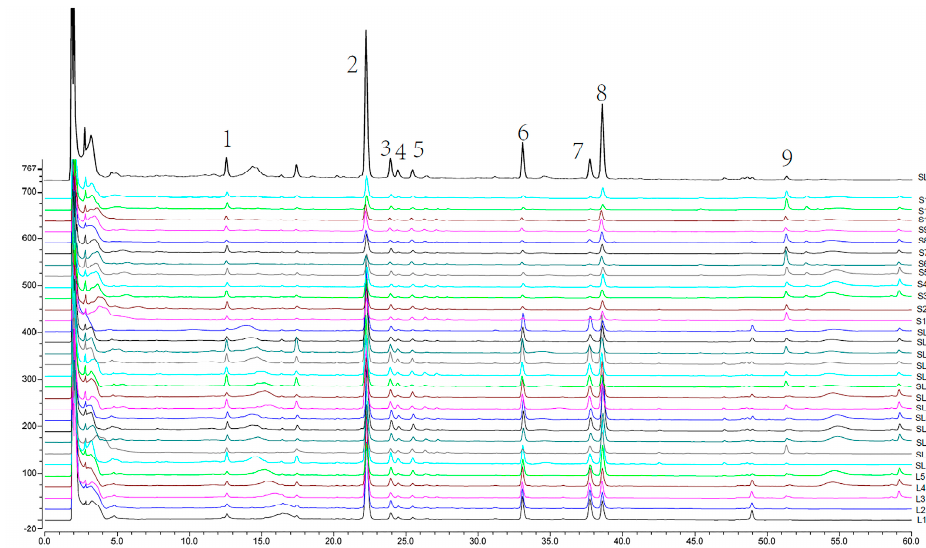
Figure 3. Chromatographic fingerprints of all AH samples. (L1–L5 are leaf samples; SL1–SL13 are stem and leaf mixed samples; S1–S12 are stem samples. Peaks 2,6,7,8 are andrographolide, neoandrographolide, 14-deoxyandrographolide, and dehydroandrographolide, respectively).